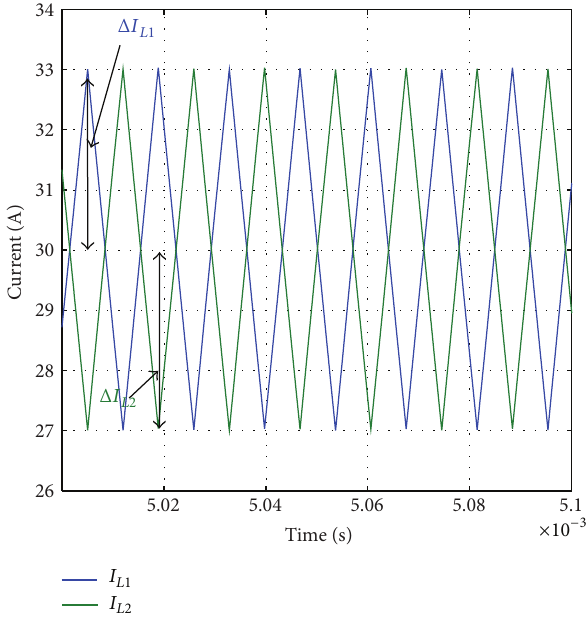
Figure 3: Inductors currents